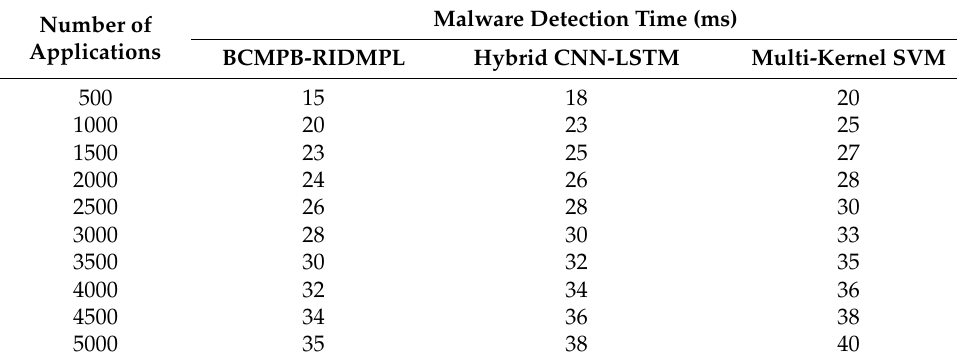
Table 4. Comparison of malware detection